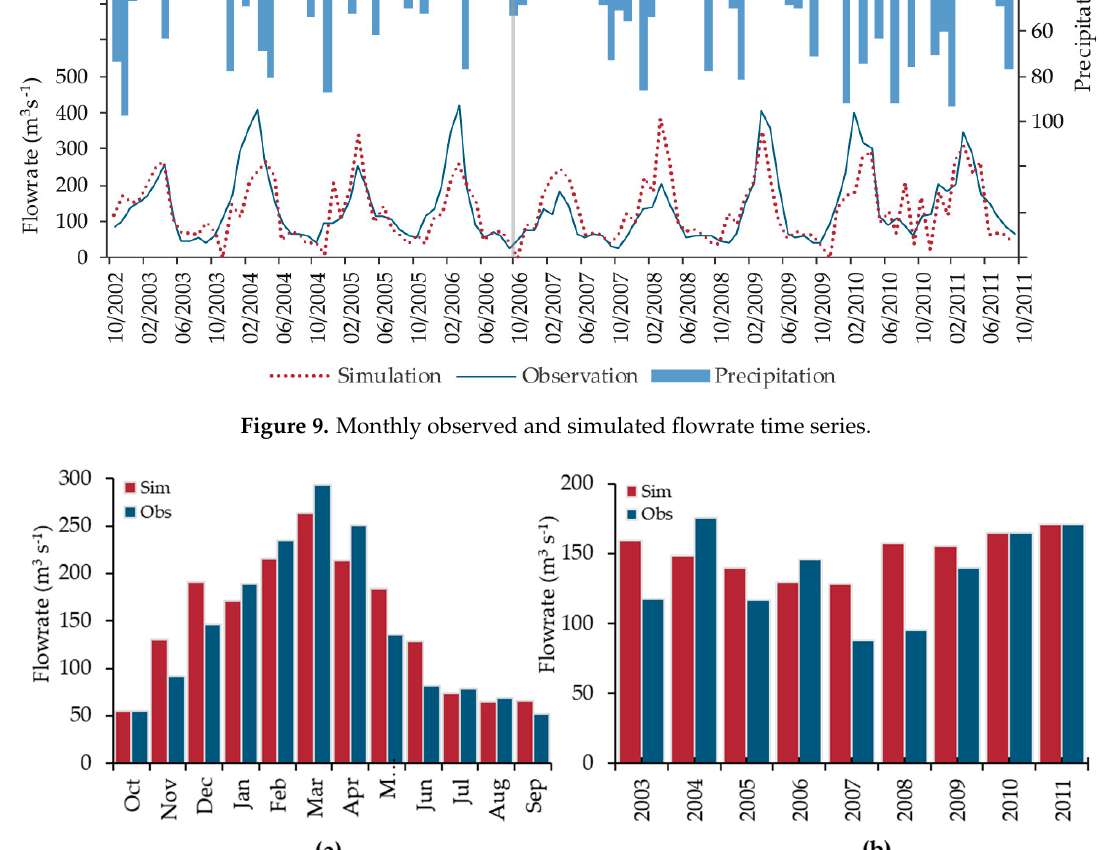
Figure 10. Comparison of: ( a ) Long-term monthly average of observed and simulated flowrates; ( b ) annual observed and simulated flowrates.